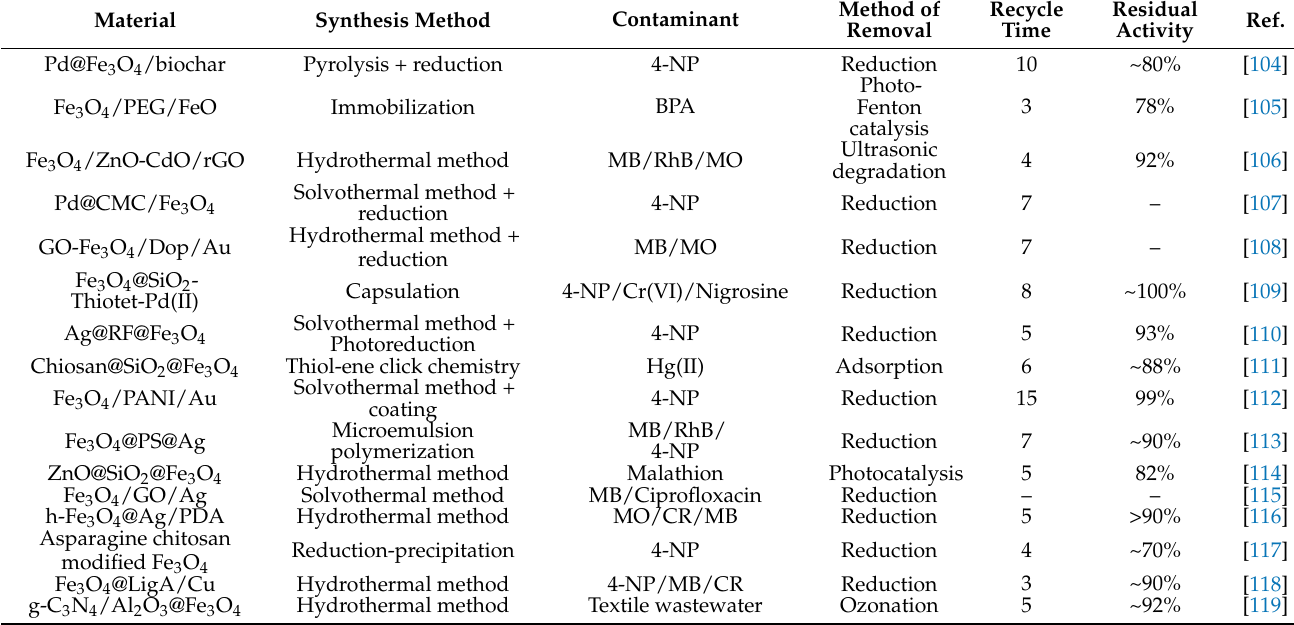
Table 2. Studies on the applications of Fe 3 O 4 as support in the removal of contaminants detailing their composition, method for synthesis, contaminant examined and proposed method of removal of contaminant, and recycling